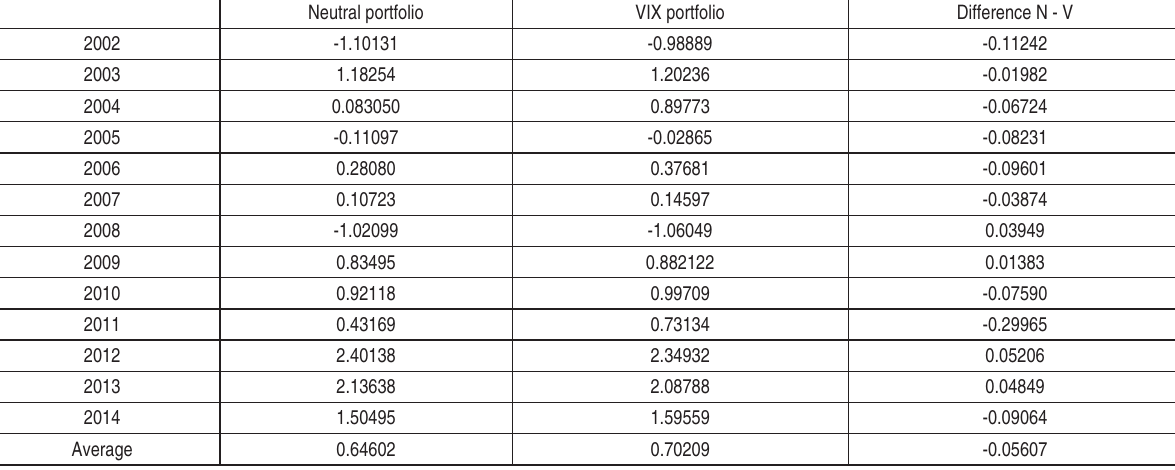
Table 5. Difference in Sharpe Ratio, VIX minus